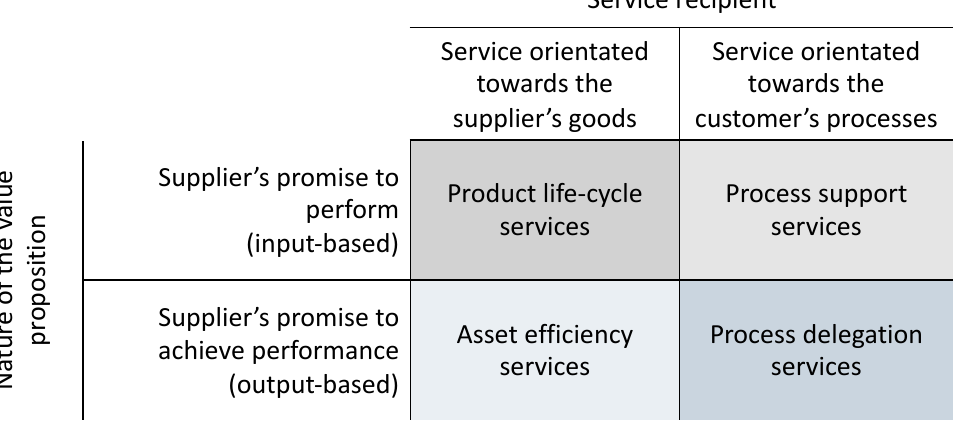
Figure 1. Service classification by Kowalkowski and Ulaga [15].